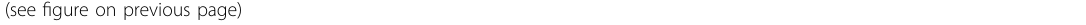
Fig. 1 Translation of non-canonical open reading frames (ncORFs) upon HBV gene expression. a The work fl ow for identi fi cation of novel ncORFs. b The subtypes of all translated ORFs identi fi ed in this study, see “ Materials and methods ” for detail. c The lengths distribution of newly identi fi ed ncORFs (blue) and previously annotated ORFs (red). See supplementary materials for detail. d A list of genes near which the expression of non-canonical ORFs (ncORFs) were altered by HBV. The peptides derived from the translation of these ncORFs were assessed by SILAC, with bar chart to indicate their relative ratios in the presence versus absence of HBV. e – h Ribosome occupancy pro fi les of host ncORFs related to GRWD1 ( e ) or PON2 ( g ). HBV + or HBV − of the translational pattern was depicted in green or blue, respectively. The annotated MS/MS spectra of two representative peptides uniquely matched to the translational products of ncGRWD1 ( f) or ncPON2 ( h ) was shown, respectively. The canonical ATG was depicted as black; the non-canonical ATG and the ncORF derived peptide were labeled as cyan. i , j The inhibitory effect of ncGRWD1 ( i ) or ncPON2 ( j ) on expression of HBV antigens was shown. ** P < 0.01, *** P < 0.001. ELISA data are presented as bar chart ( n =